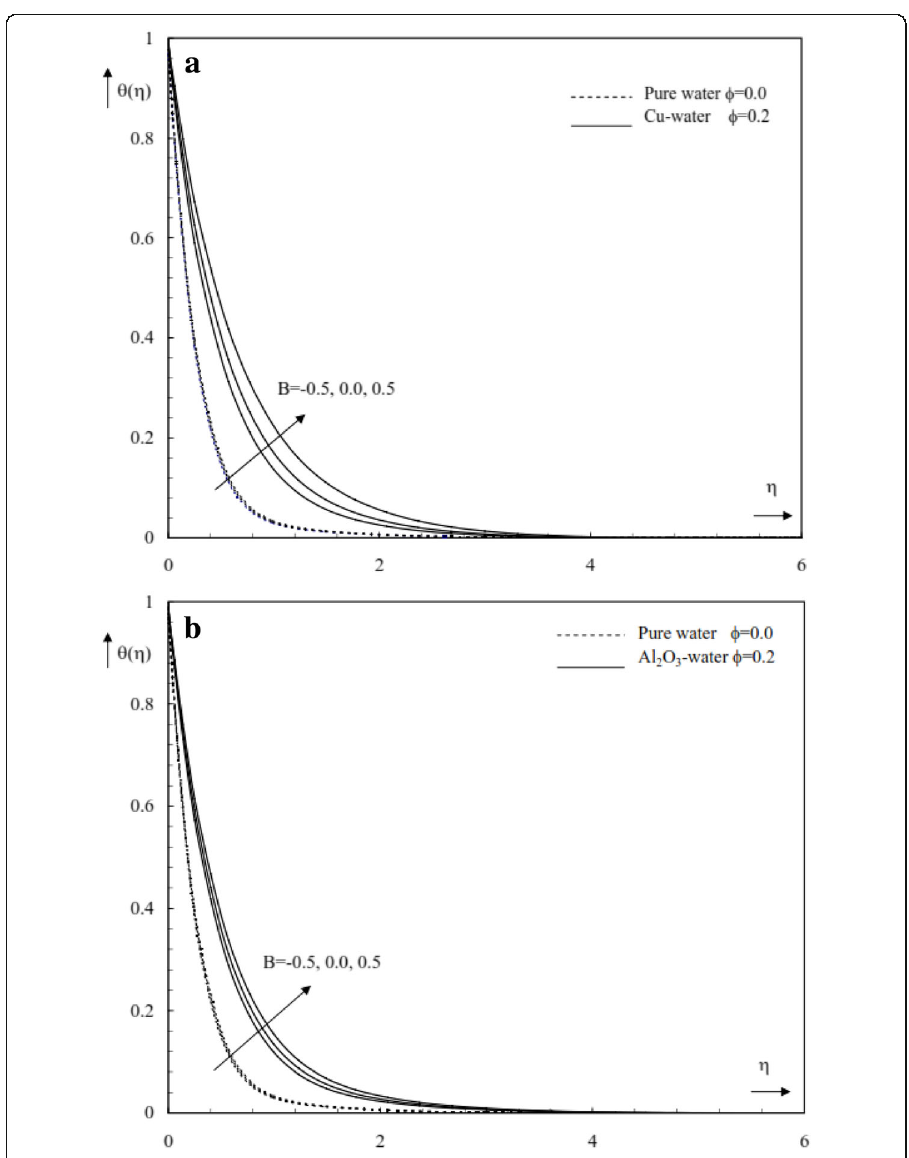
water and b Al 2 O 3